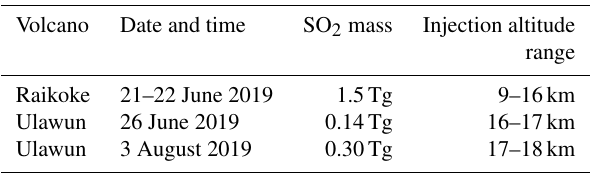
Table 1. Characteristics of the model setup accounting for volcanic injections of SO 2 . The injections have been initialized between 18:00 and 00:00UTC. Volcano Date and time SO 2 mass Injection altitude